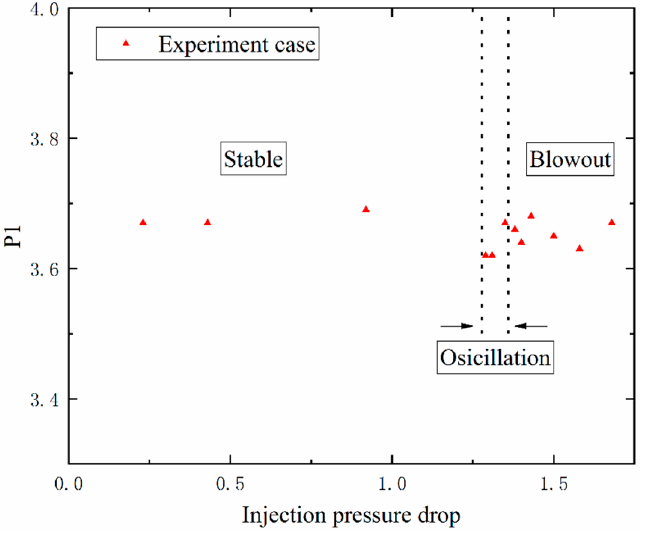
Figure 9. Schematic diagram of the combustion modes under different injection pressure drops.